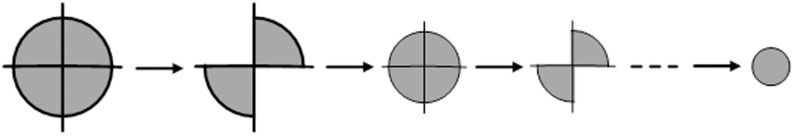
Schema of quartering.